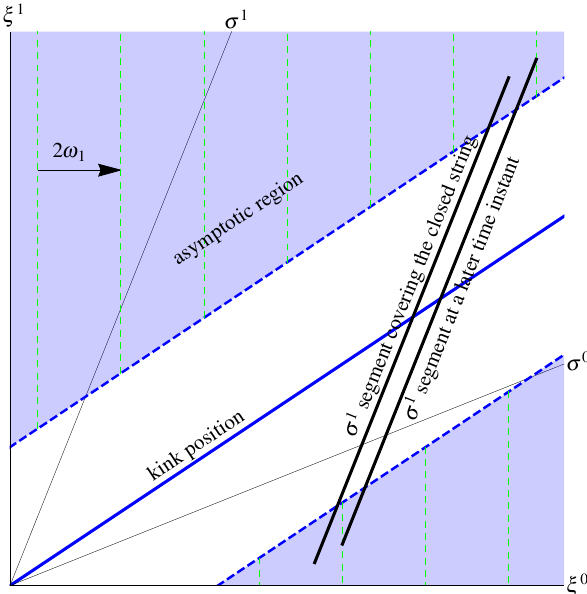
Fig. 15 Taking advantage of the asymptotic periodicity properties of thesine-Gordoncounterparttoformanapproximatefiniteclosedstring. Notice that the σ 1 segment that covers the closed string moves with the velocity of the kink and not alongside the σ 0 axis